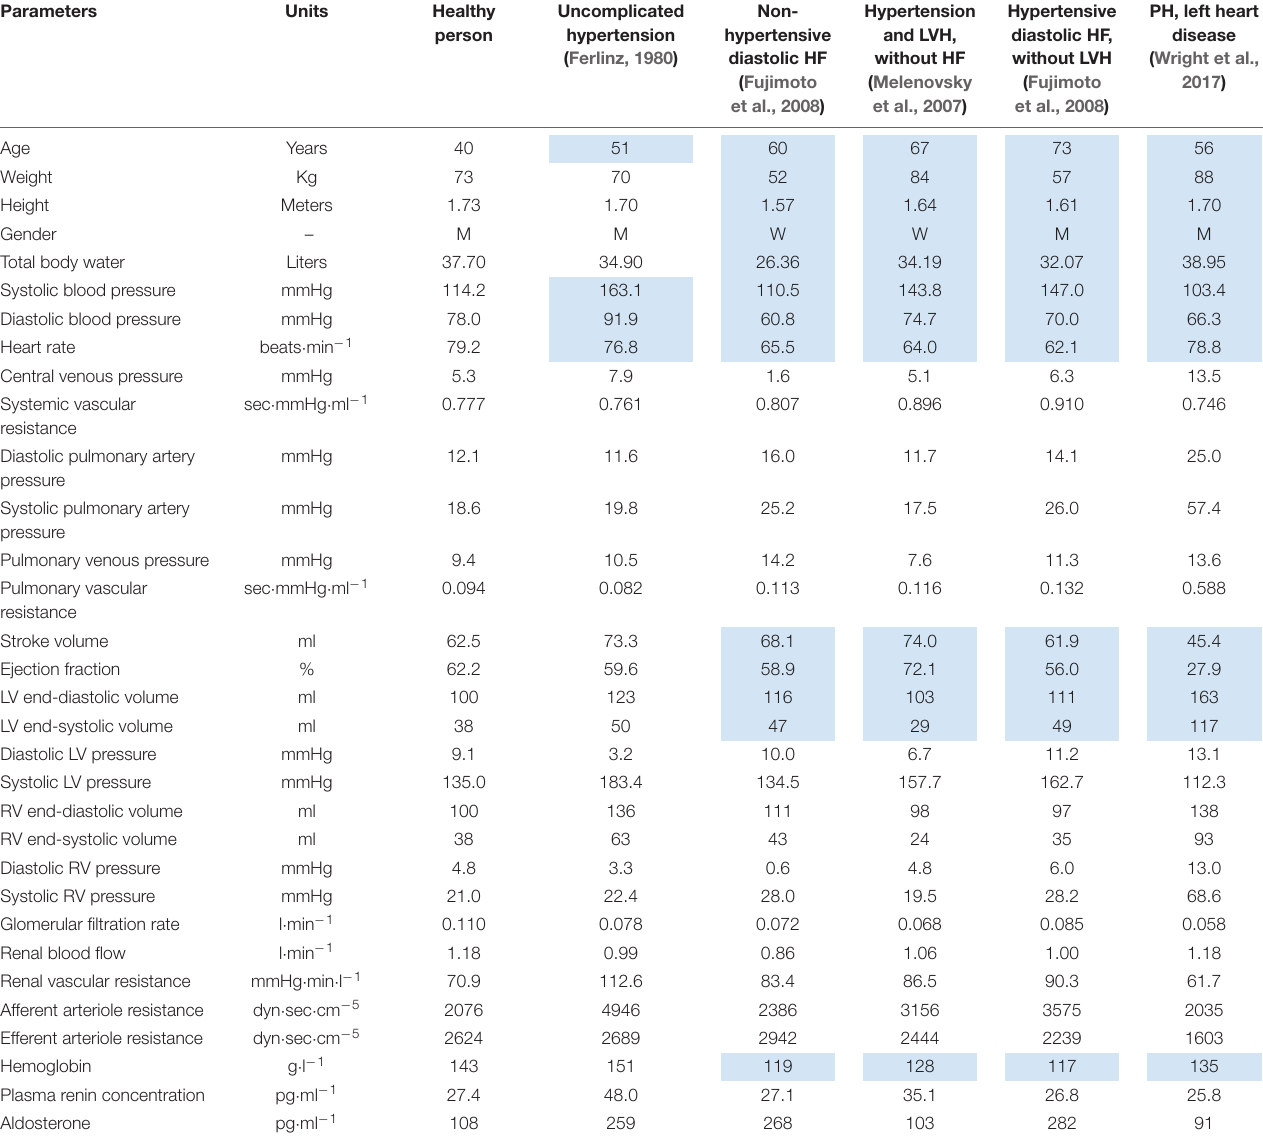
TABLE 2 | Equilibrium values representing abstract patients with different cardiovascular diseases. Parameters Units Healthy